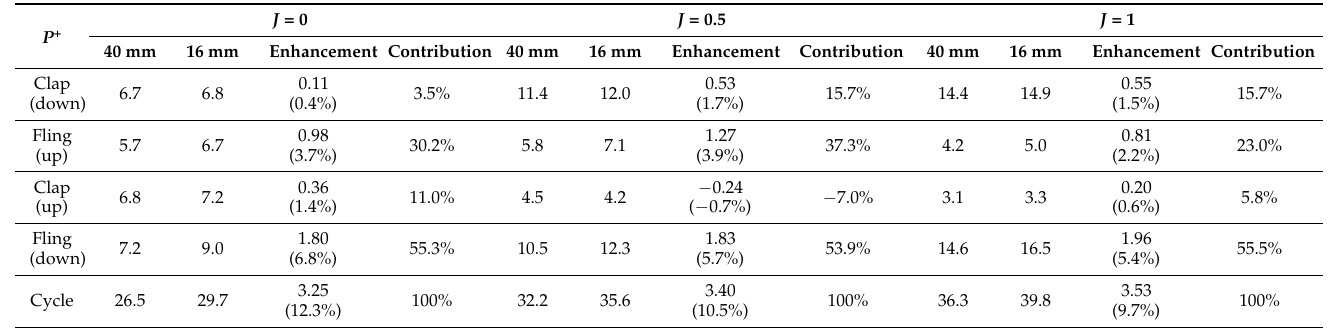
Table 4. Contribution of clap and fling phases to the mean power consumption